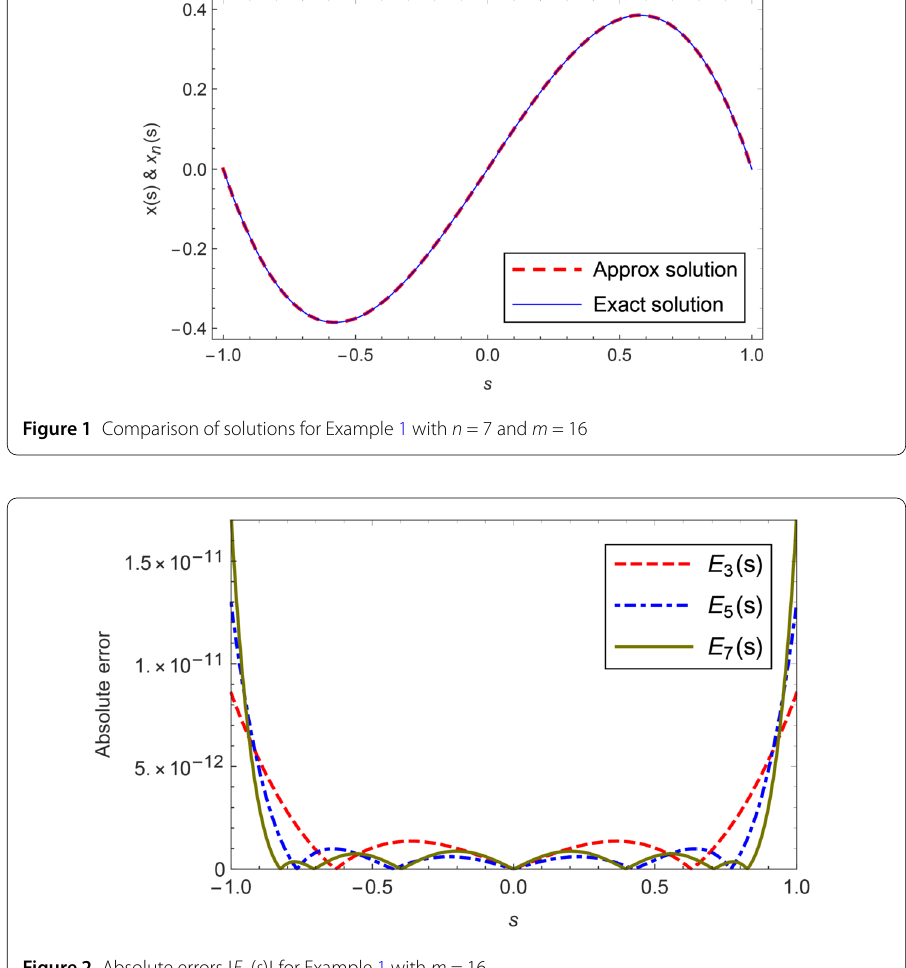
Figure 2 Absolute errors | E n ( s ) | for Example 1 with m =